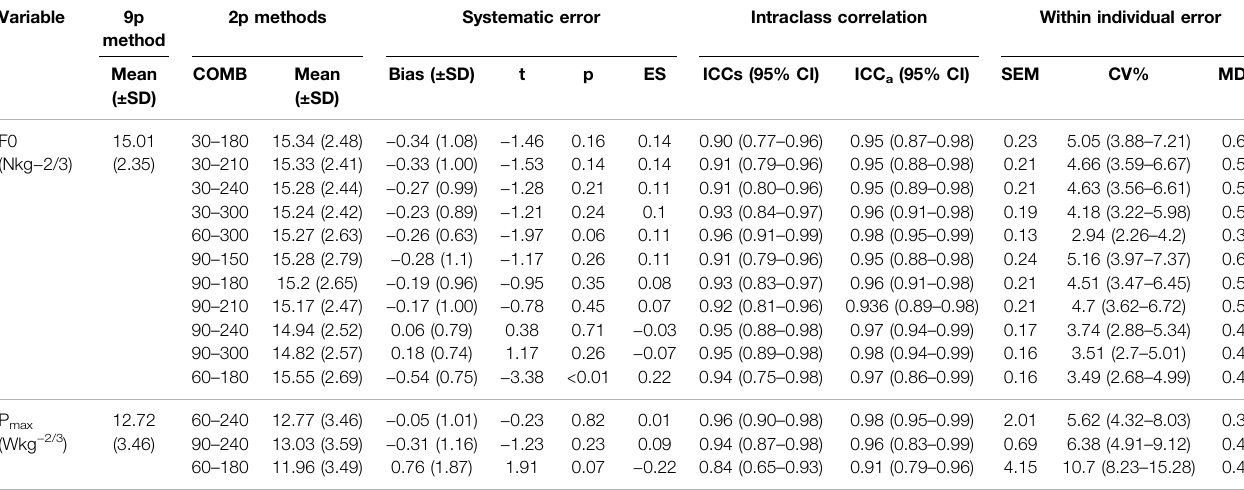
TABLE 4 | 2-point methods with the highest validity for KF task. Variable 9p 2p method